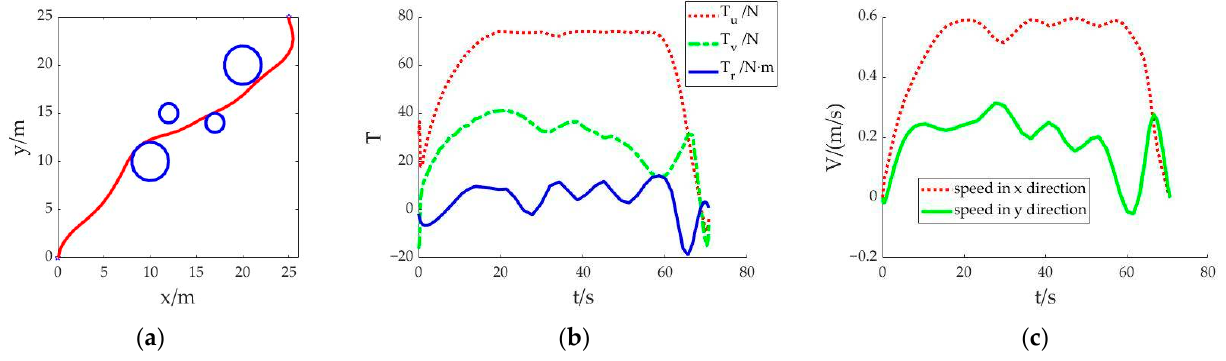
Figure 2. Result of each state in scenario 2: ( a ) Trajectory planning of the AUV; ( b ) Variation diagram of thrust; ( c ) Diagram of velocity change in x and y directions.